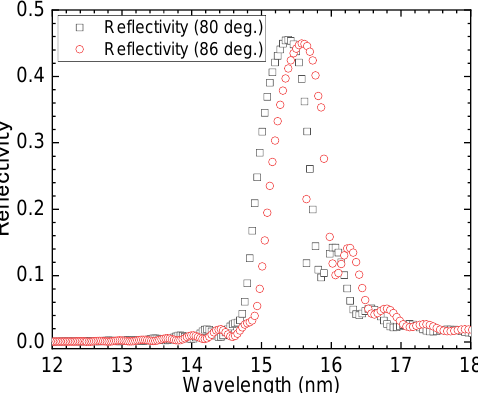
Figure 2. Reflectivity of the Mo/Si multilayer concave mirror for two incident angles.